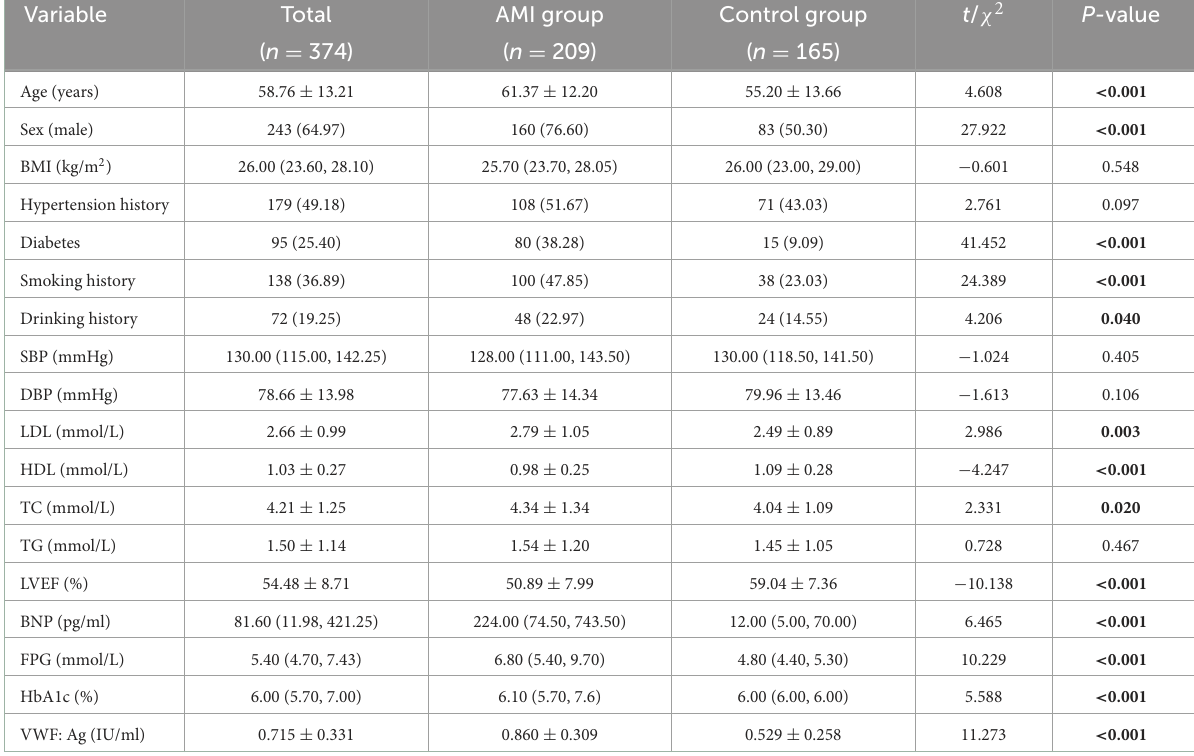
TABLE 1 Basic data comparison between patients in the AMI group and the control group.